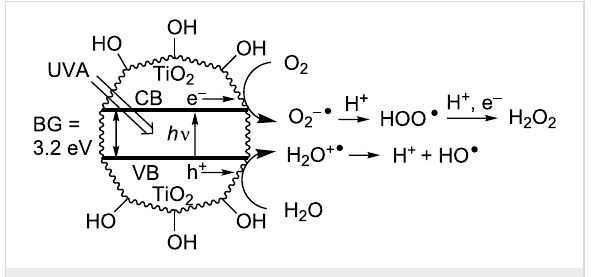
Figure 2: Photoredox activity of TiO 2 with moist air.